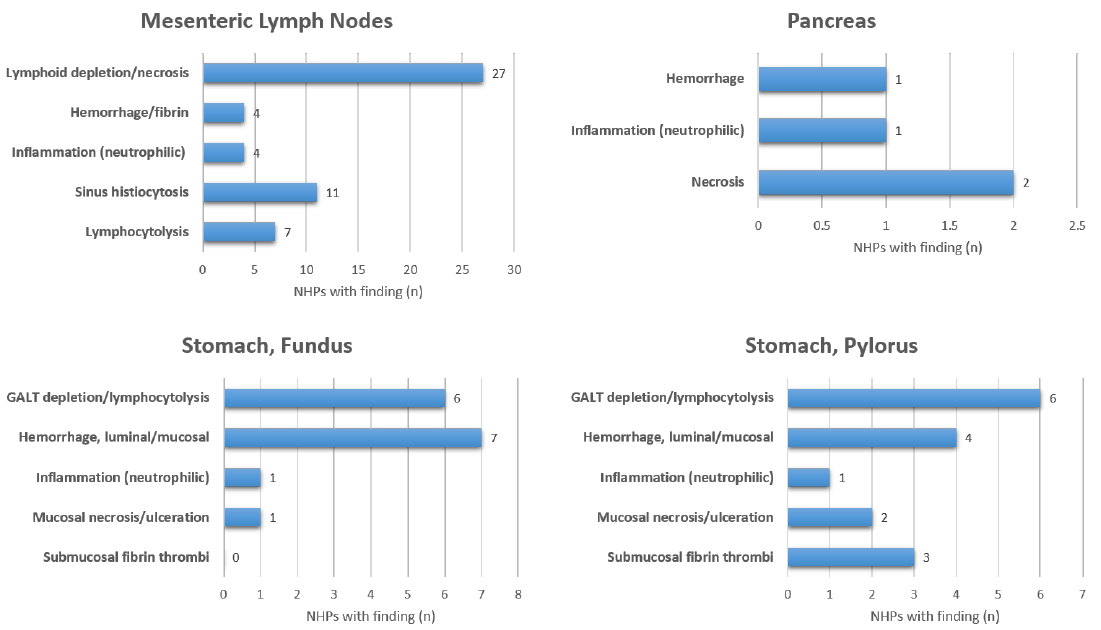
Figure 1. Summary of histopathologic findings for mesenteric lymph nodes, pancreas, and stomach in Ebola challenged rhesus macaques ( n = 31).